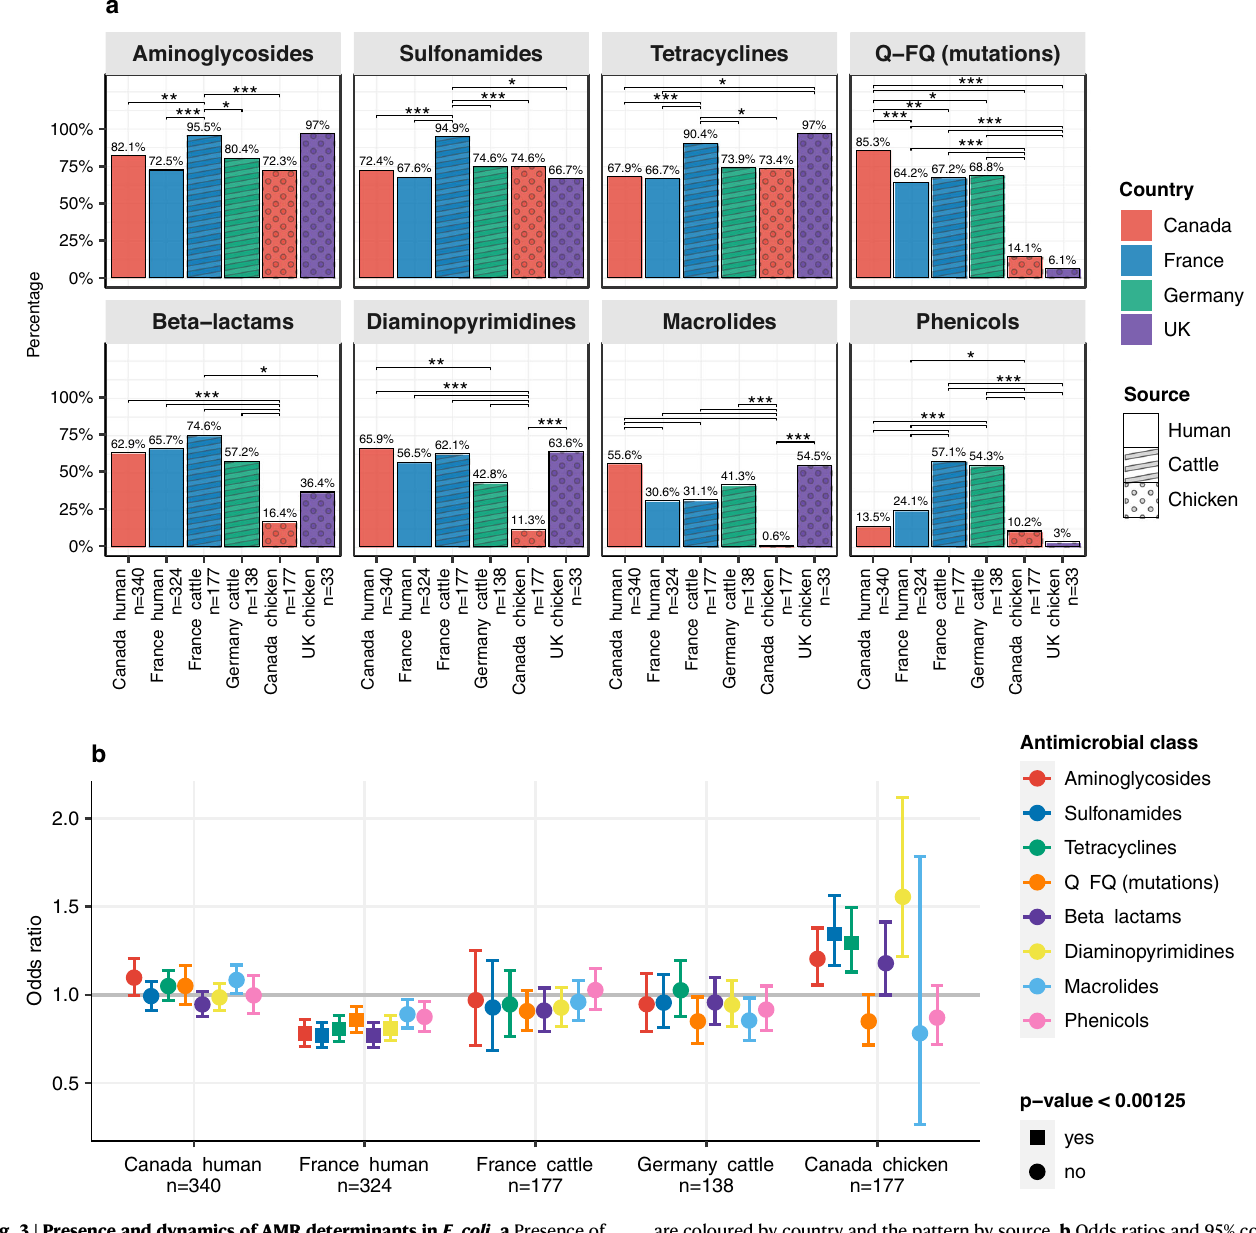
are coloured by country and the pattern by source. b Odds ratios and 95% con- fi dence intervals (coloured as per inset legend) demonstrating change in